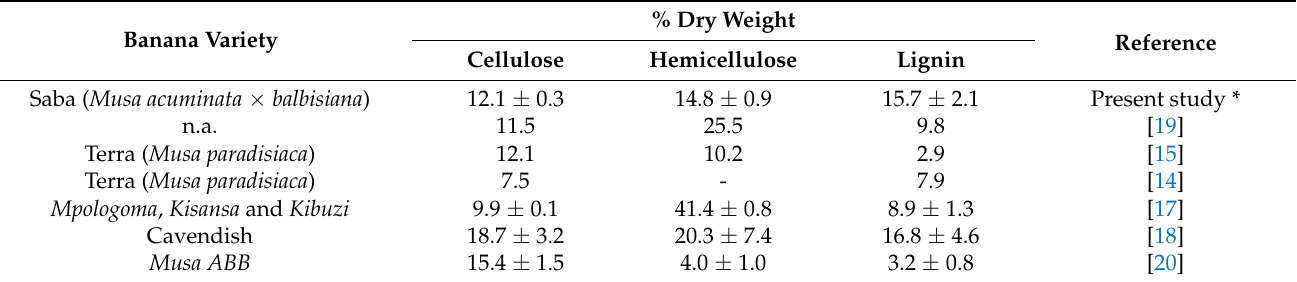
Table 2. Chemical compositions of BP